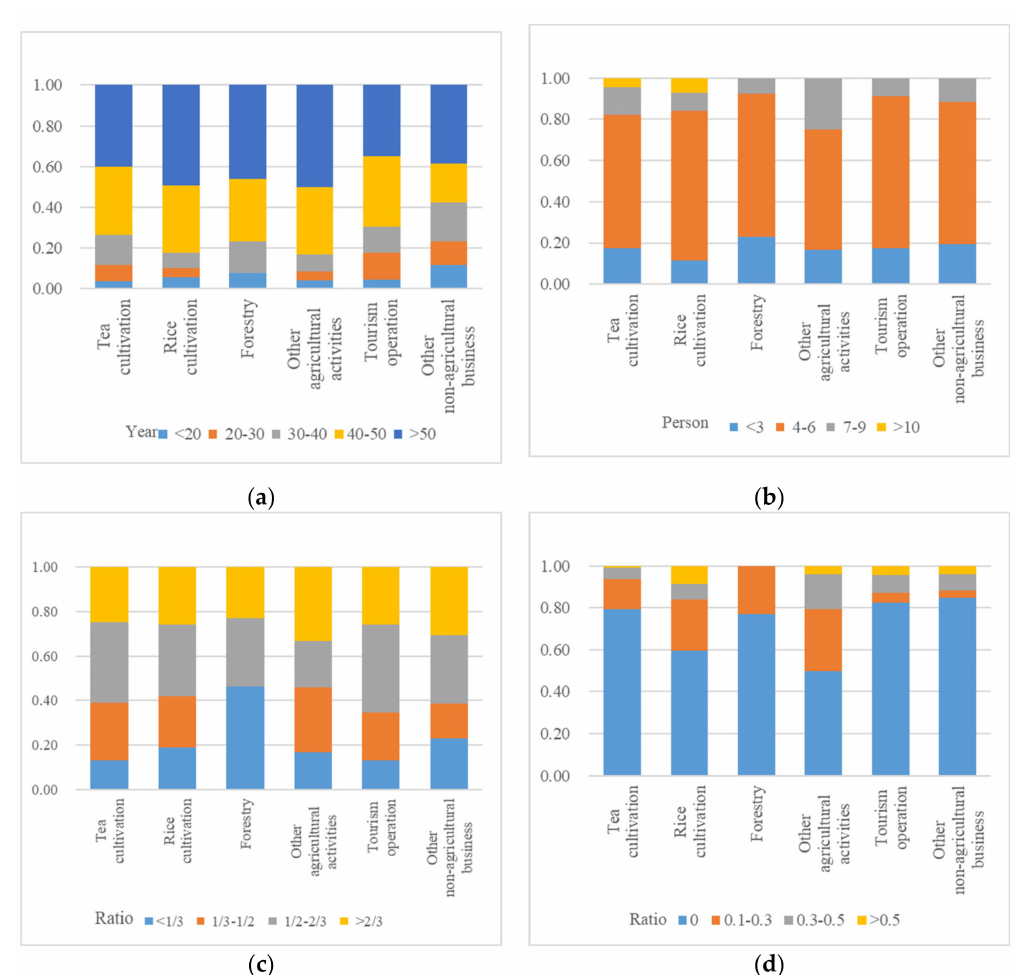
Figure 2. Distribution of some features of households engaged in different livelihood activities. Columns show the pro- portion of each category for the feature:length of residence ( a ), family population, ( b ) labour conditions: labour ratio ( c ), migrant worker ratio ( d